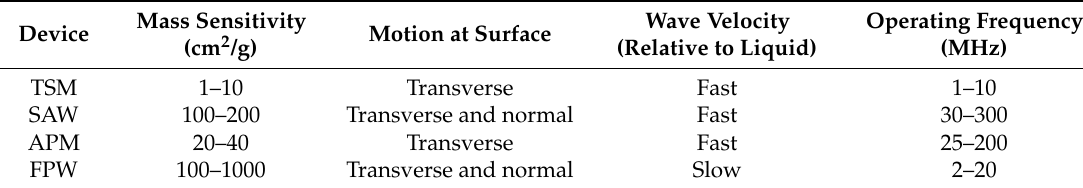
Table 1. Comparison of four main types of acoustic